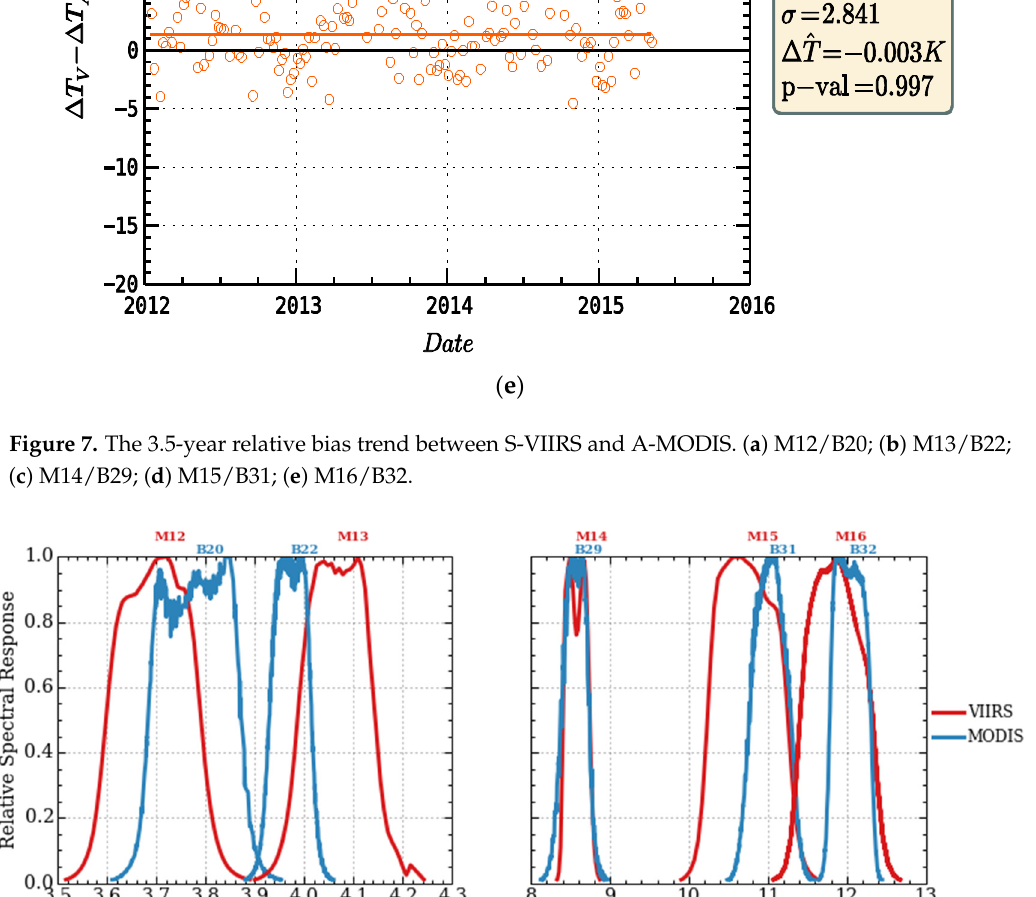
Figure 8. RSR Curves for matching TEB for VIIRS and MODIS. Table 2. Relative Bias drift [K/3.5 years] between S-VIIRS and